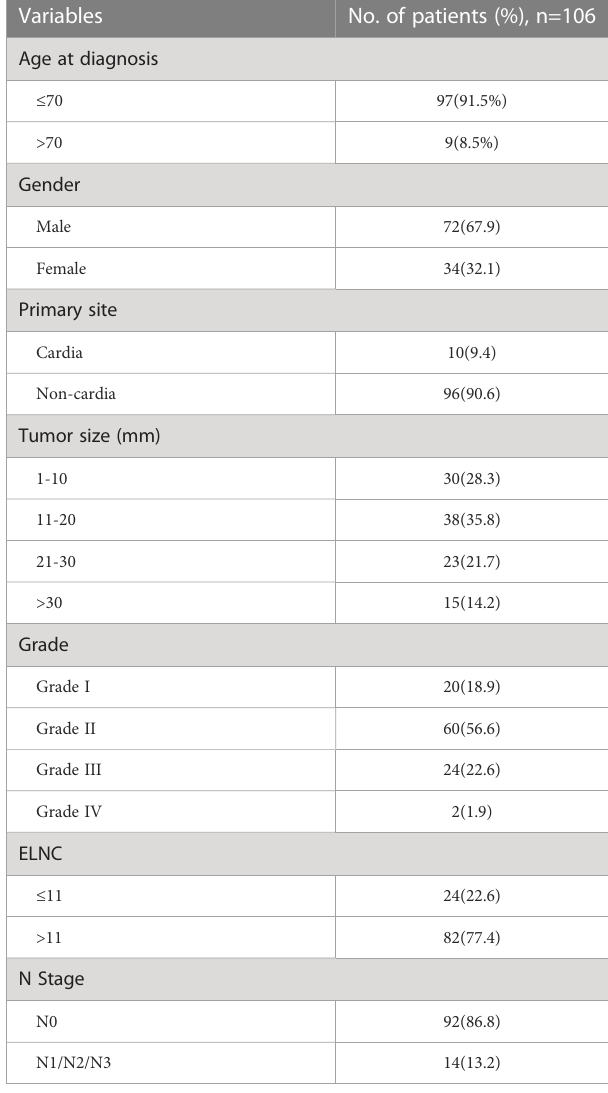
TABLE 2 The clinicopathological characteristics in the Second Hospital of Lanzhou University.